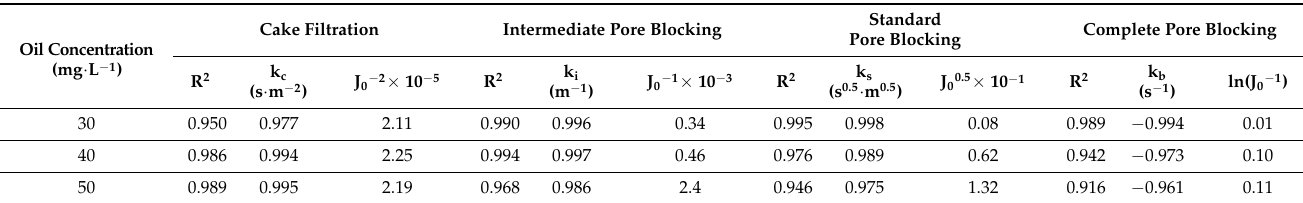
Table 3. Related parameters of different pore blocking models with different oil